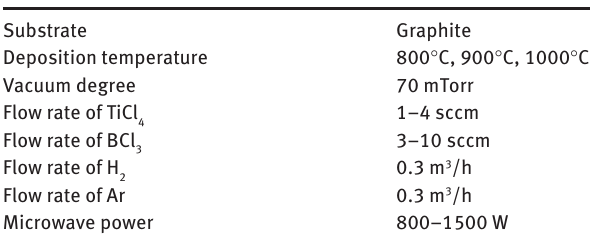
Table 1: Deposition conditions of TiB CVD.